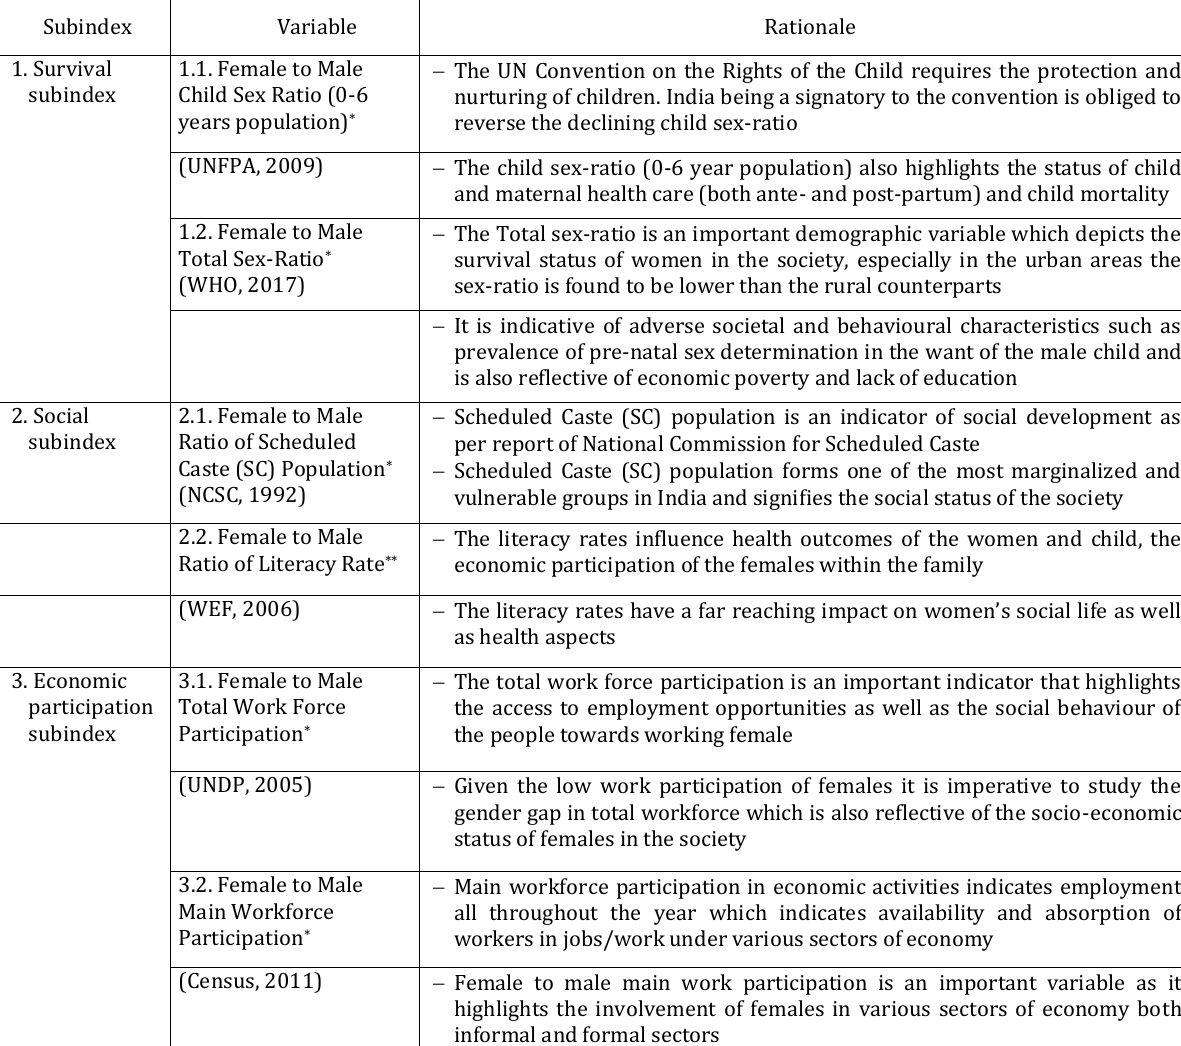
Table 1. Subindices and variables of the Gender Gap Index, for Sehore M.C